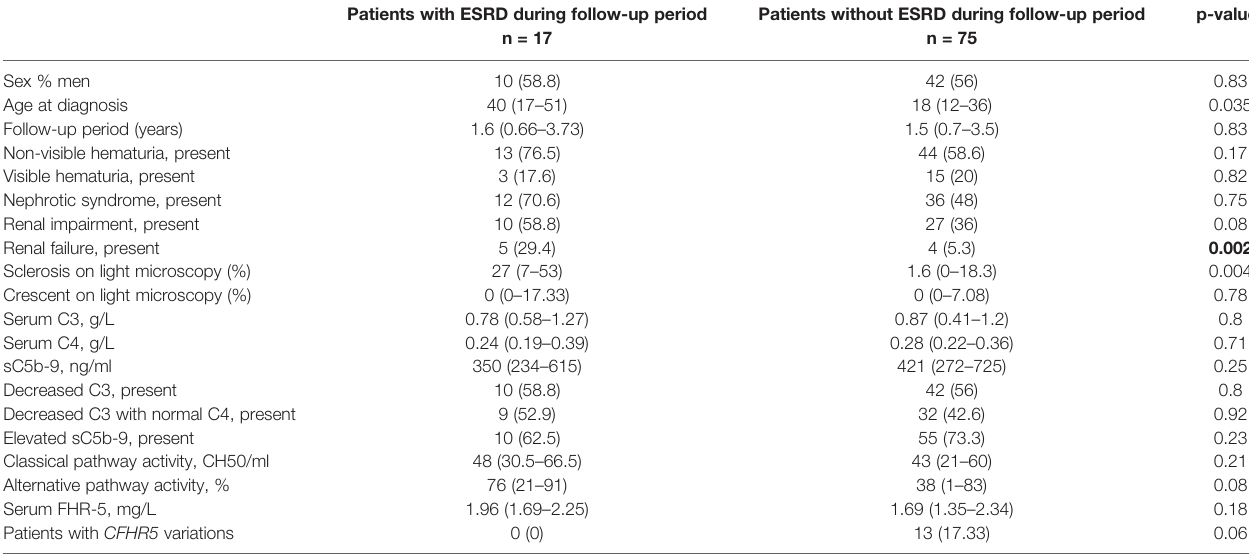
TABLE 5 | Clinical characteristics of patients at the time of diagnosis with or without ESRD development during the follow-up period. Patients with ESRD during follow-up period Patients without ESRD during follow-up period n = 17 n = 75